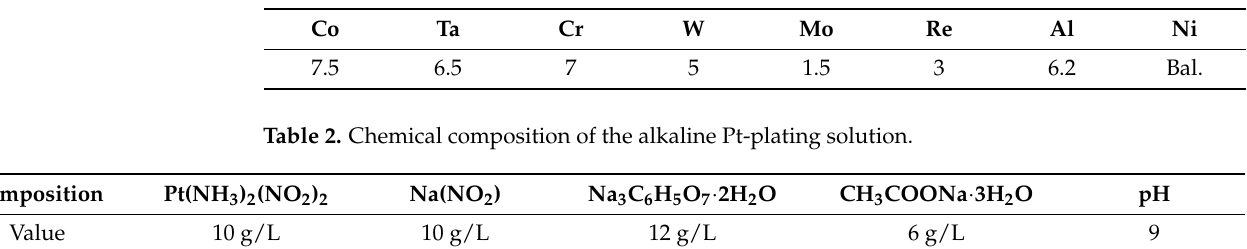
Table 1. Normal chemical composition (wt.%) of single-crystal superalloy DD419.